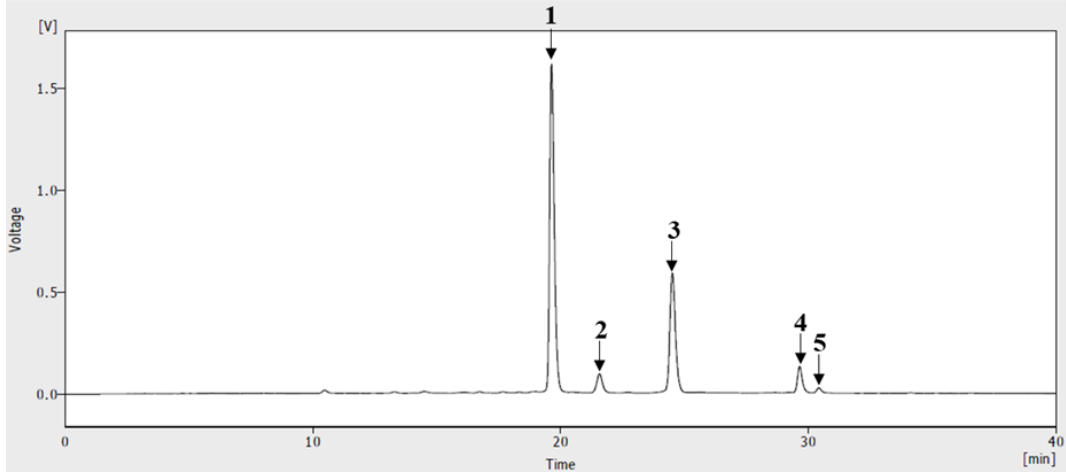
Figure 1. HPLC chromatogram of ABF ® , anthocyanin enriched Aronia melanocarpa fruit extract at 520 nm. Peak numbers correspond to the following compounds: 1. cyanidin-3-galactoside; 2. cyanidin-3-glucoside; 3. cyanidin-3-arabinoside; 4. cyanidin-3-xyloside; and 5. cyanidin chloride.